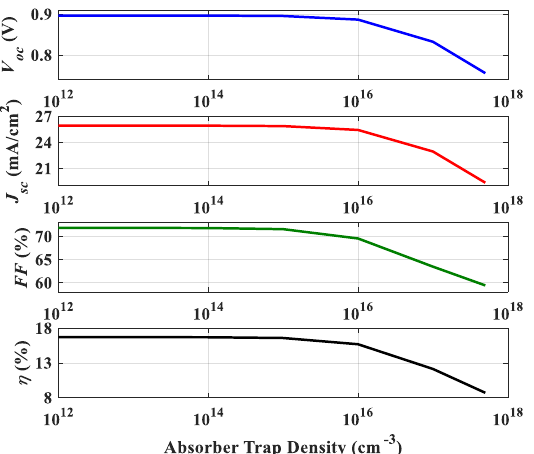
Figure 15. The HTL-free configuration photovoltaic parameters with various defect density ( N t ) in both n-CH 3 NH 3 SnI 3 and p-CH 3 NH 3 SnI 3.